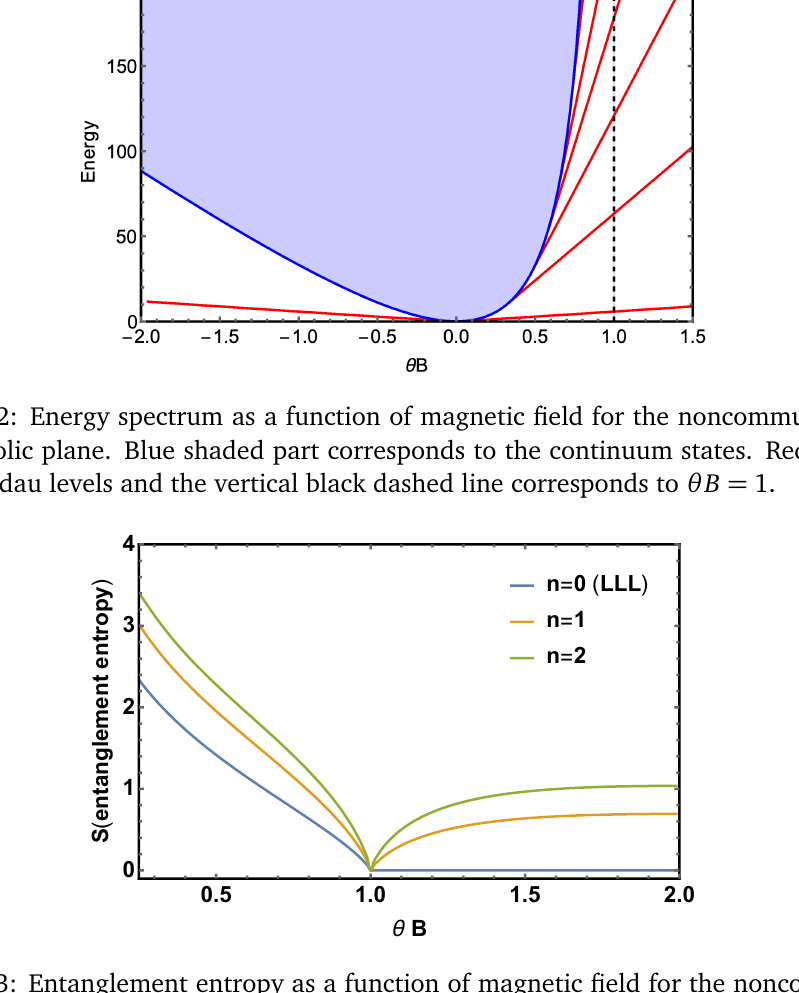
Figure 3: Entanglement entropy as a function of magnetic field for the noncommu- tative hyperbolic plane (only Landau Level states are